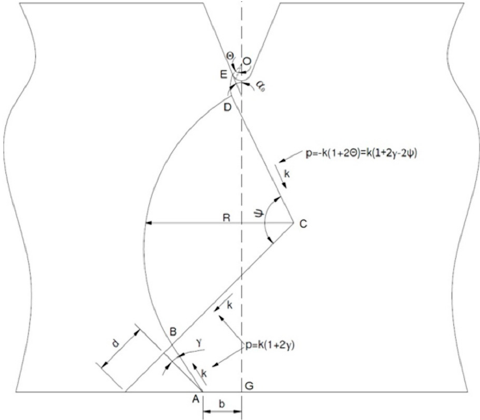
Figure 2. One half of the plain strain slip-line field, reproduced from [12], with permission of Elsevier, 1968.